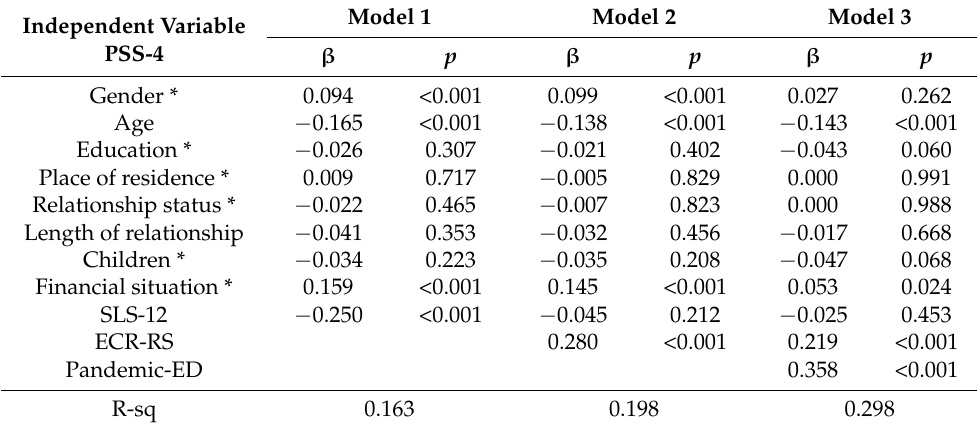
Table 6. Hierarchical regression for the PSS-4 variable. Variables in the model (N = 1405).